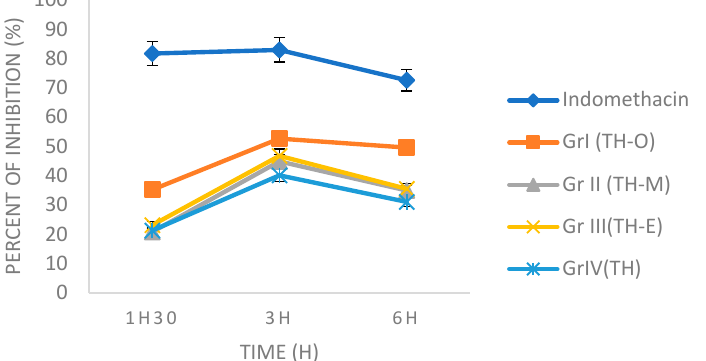
Figure 2. Effects of indomethacin, Thyme honey and mixtures on experimental trauma-induced rat paw edema. TH: Thyme honey; TH-O: mixture of honey and O. vulgare EO; TH-M: mixture of honey and M. spicata EO; TH-E: mixture of honey and E. globulus EO. Three hours after carrageenan administration, the mixture of thyme honey and O.